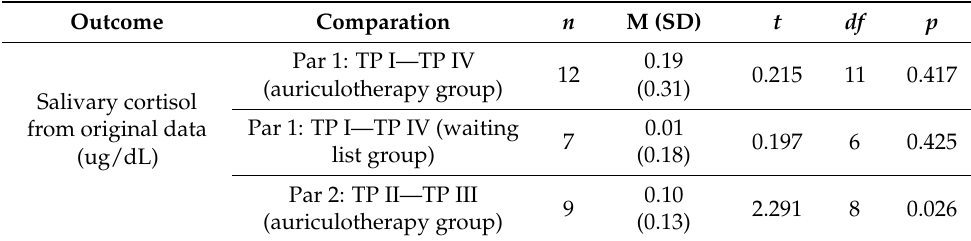
Table 4. Outcome of the investigation data by pared samples t -test given as mean and standard deviations of anxiety levels measured by salivary cortisol.